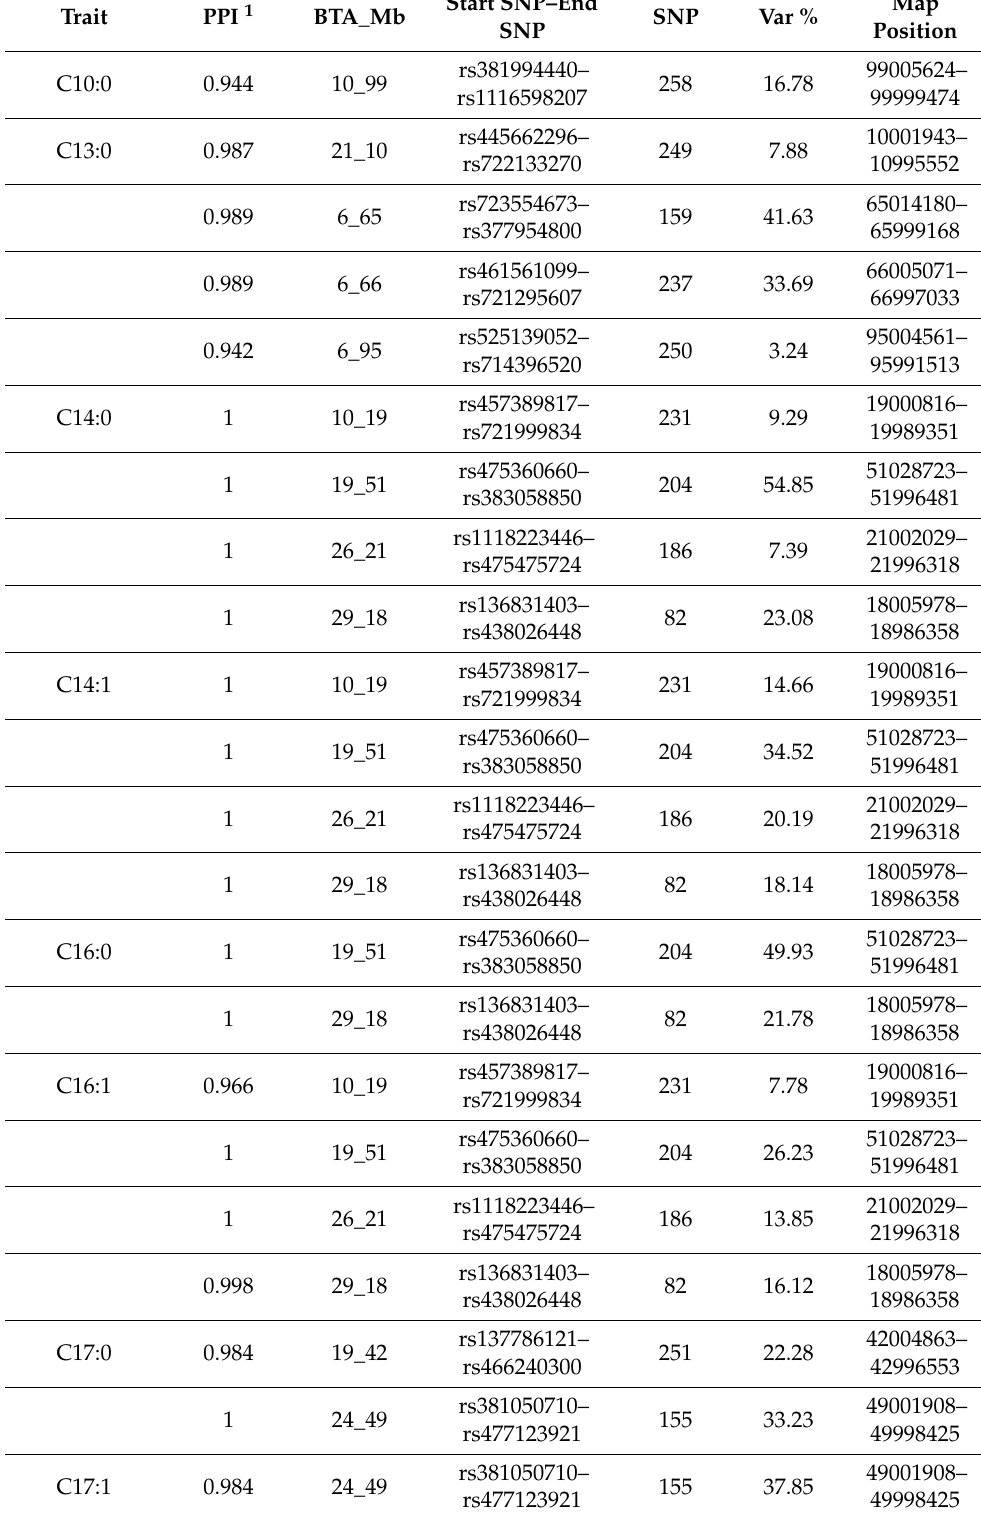
Table 3. 1-Mb SNP windows with PPI 90% or above for fatty acids on fat percent